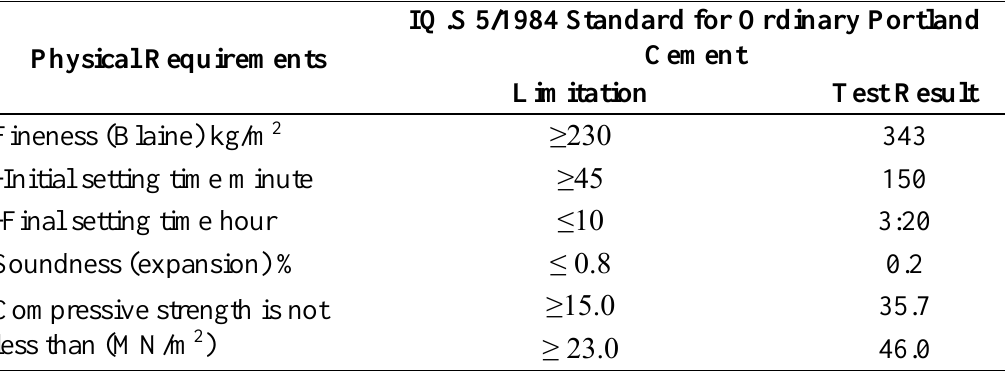
Table 2. Physical properties of cement